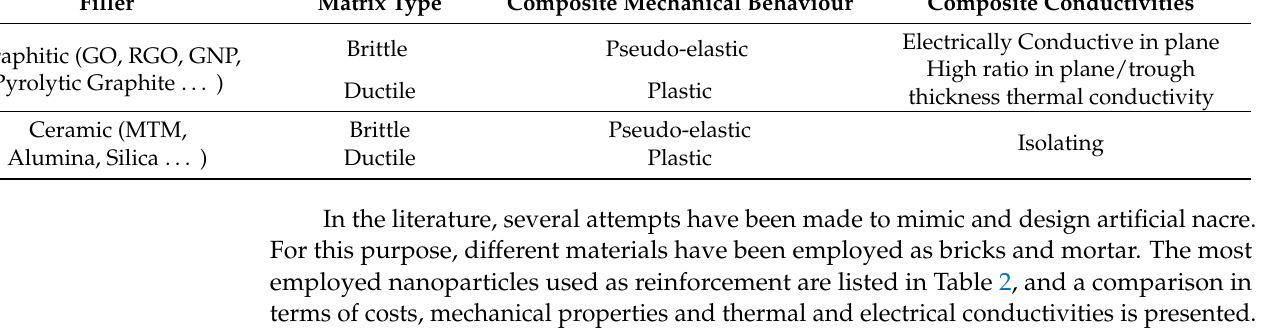
Table 2. Comparison between 2D nanoplatelets employed as reinforcement in B&M